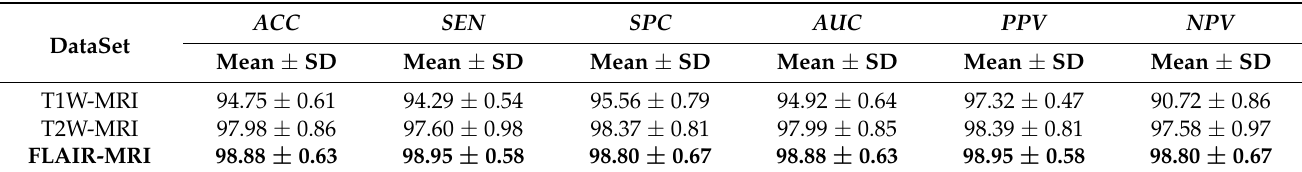
Table 9. Highest classification performance of three MRI sequence data.